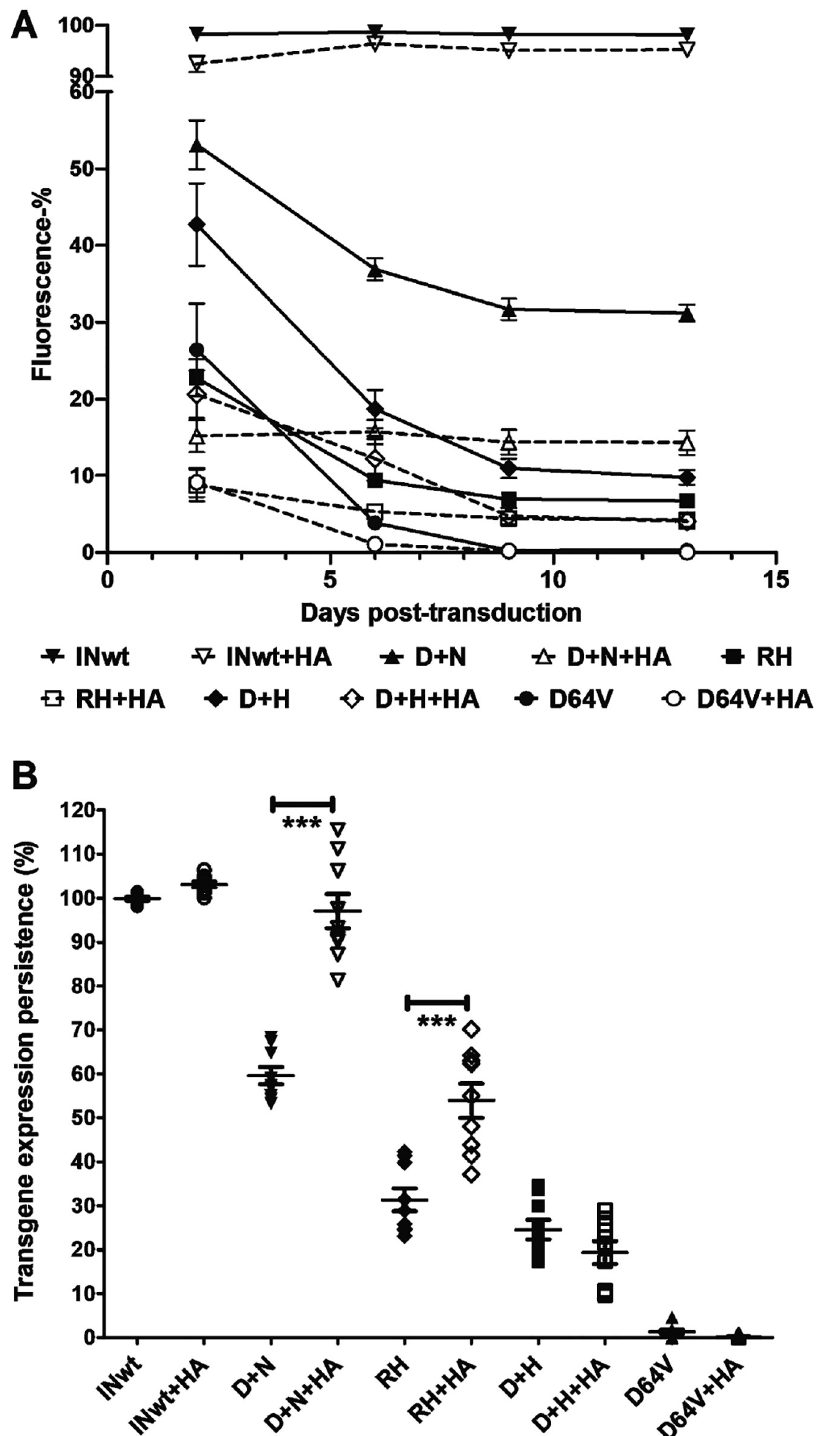
Fig 2. Characterisation of transgene expression stability in IN-I-PpoI transduced MRC-5 cells. A . Expression of EGFP-transgene from MRC-5 cells transduced with 7.5K vector particles/cell, measured on days 2, 6, 9 and 13 post- transduction by flow cytometry. Mean ± SEM, n = 9. B . Transgene expression persistence on day 13 post-transduction: presented as the percentage of day 2 transgene expression retained at day 13. Mean ± SEM, n = 9. ��� = P < 0.001, one- way ANOVA and Tukey’s multiple comparison